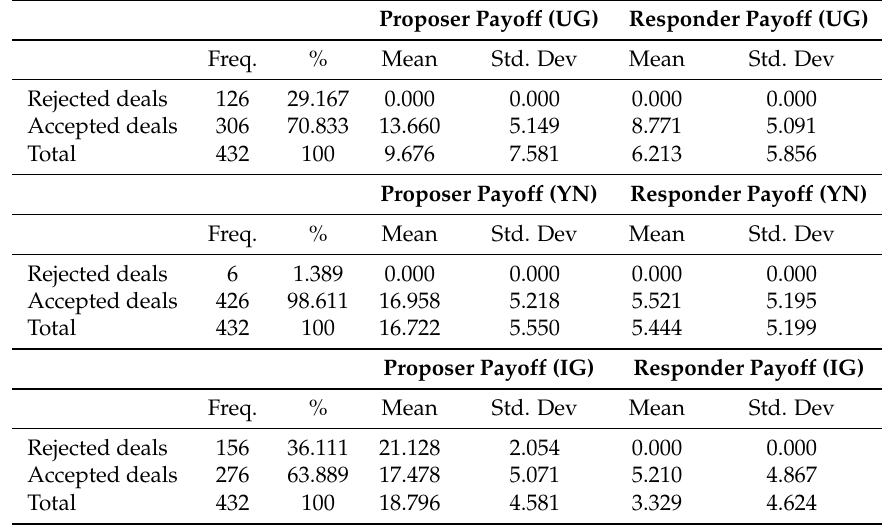
Table 5. Payoff analysis by acceptance rate (actual